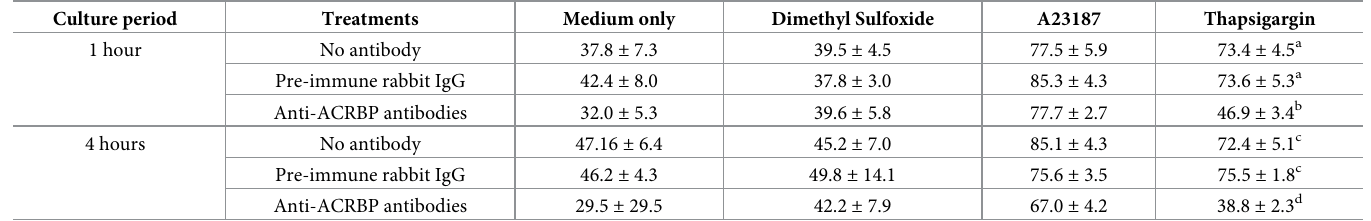
Table 4. Impact of anti-ACRBP on the AR induced by thapsigargin and A23187 # . Culture period